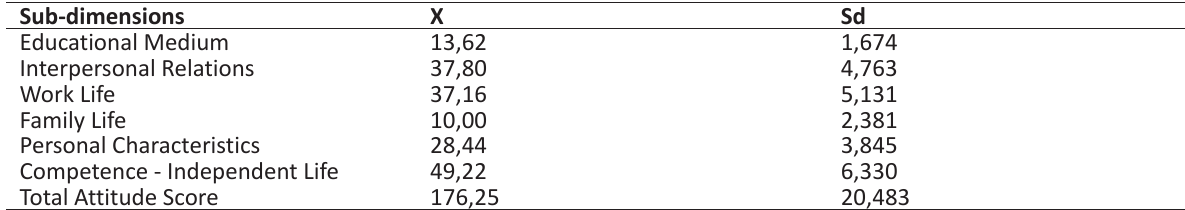
Table 2. Definitive Statistics on the Attitude Levels of the Participants towards the Handicapped Sub-dimensions